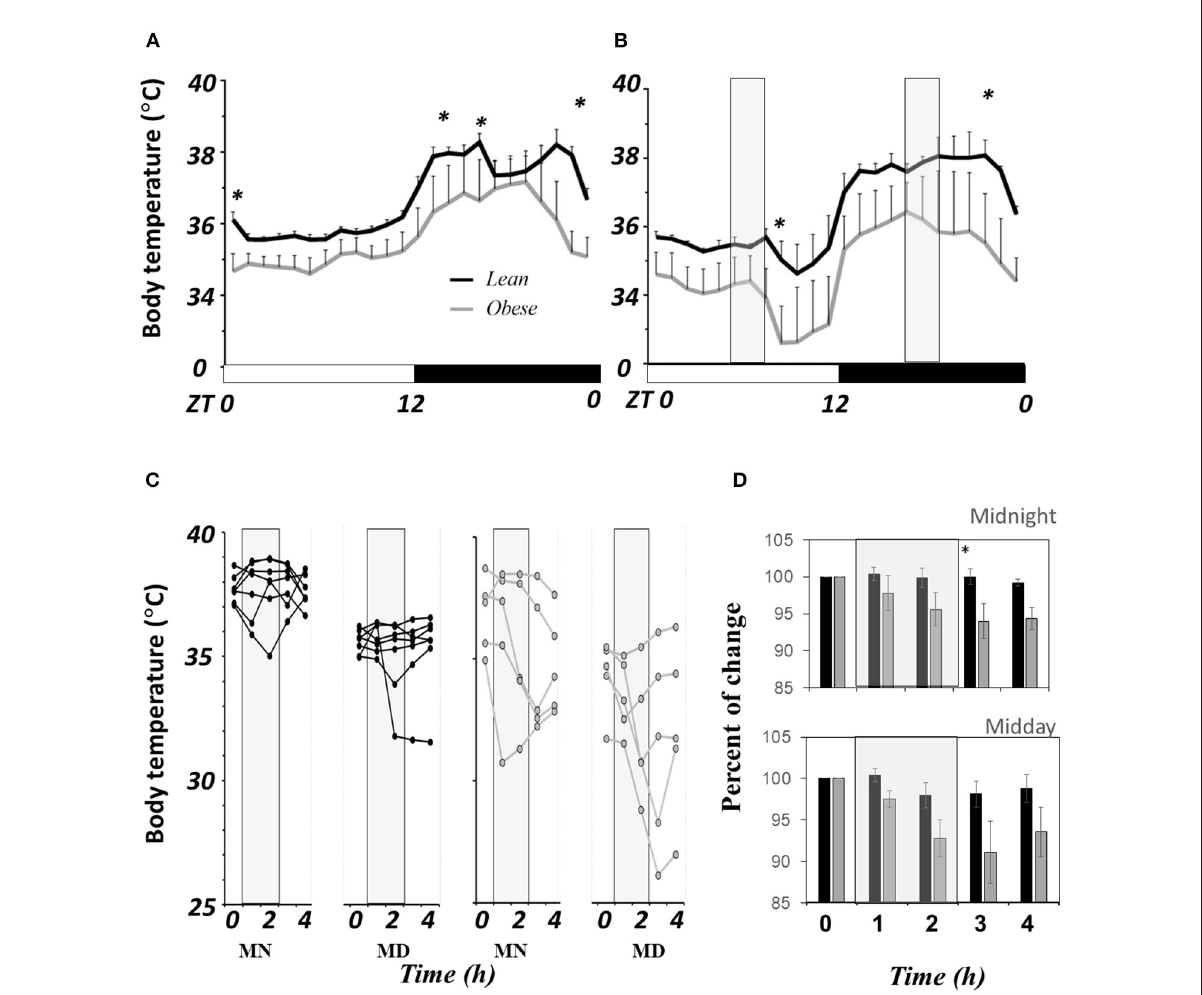
FIGURE3 Comparative of core body temperature in N. alstoni . Lean (black lines and bars, n = 7), Obese (gray lines or bars, n = 5). (A) Hour by hour average ± SEM of 3 days in LD; (B) Daily profile temperature and exposure to a drop in environment temperature (12 ◦ C, light gray bars), (C) first day individual changes in BT before during and after the cold exposure; (D) Percent change of body temperature before, during and after cold pulses vs. Time 0. * Significant differences intergroup ( P <